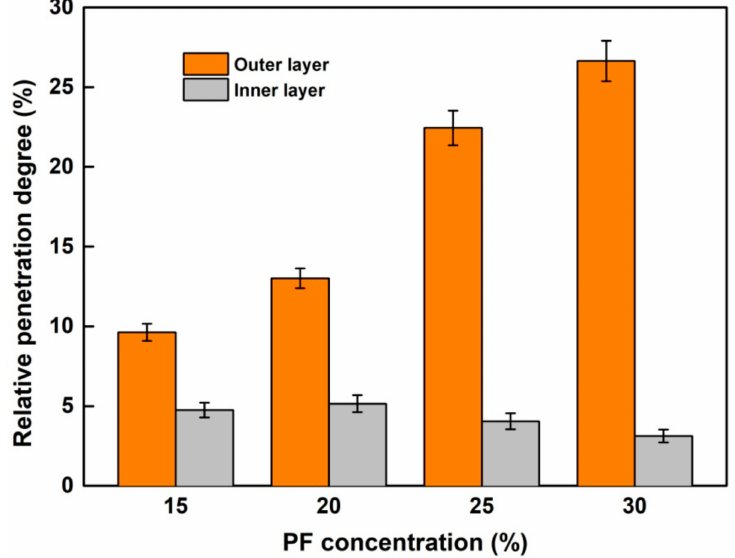
Figure 5. The relative penetration degree (RPG) of PF resin in the wood tracheid lumens.